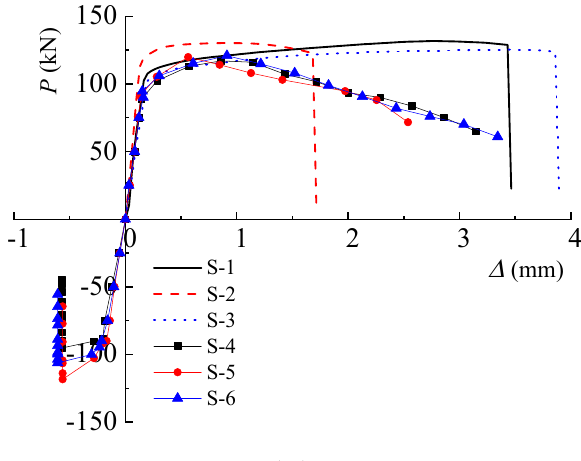
Figure 11. Skeleton curves.